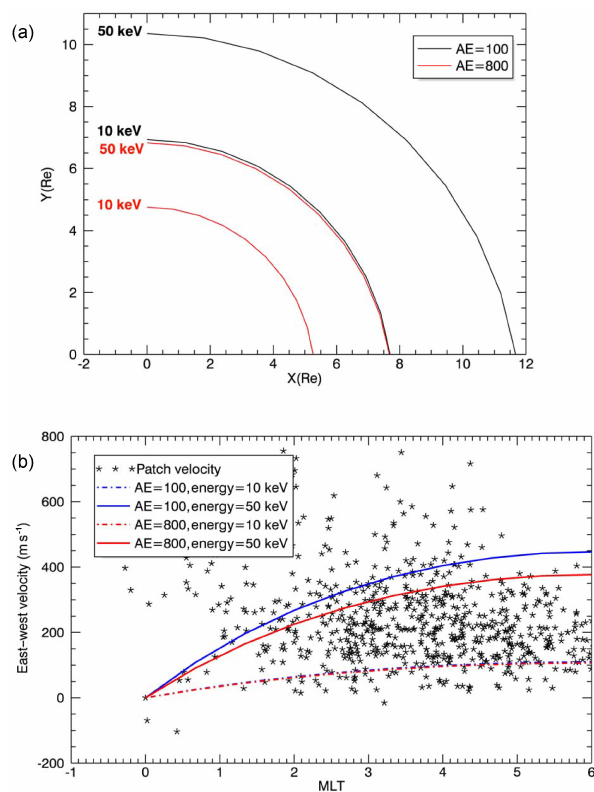
Figure 4. (a) The inner boundaries of 45 ◦ pitch angle electrons with energy of 10 and 50keV on the equatorial plane. Red and black represent boundaries for AE = 800 and AE = 100, respec- tively. (b) Distribution of MLT versus patch eastward velocity for the events with convection velocities inferred from the electric field model at the inner boundaries of electron plasma sheet with each AE index and electron energy. The convection velocities have been mapped into the ionosphere and the corotation has been